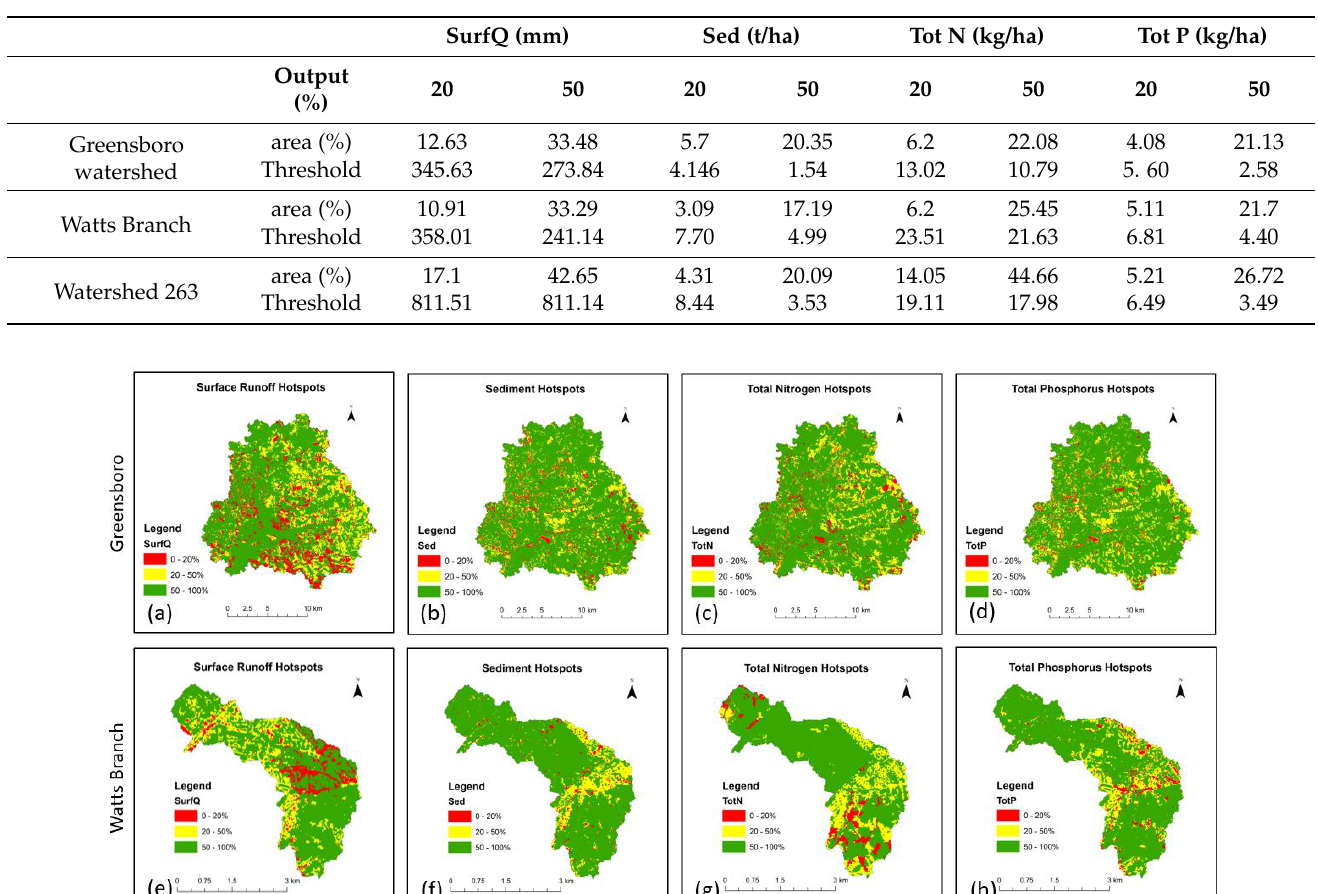
Table 4. Hotspot thresholds in three real watersheds.